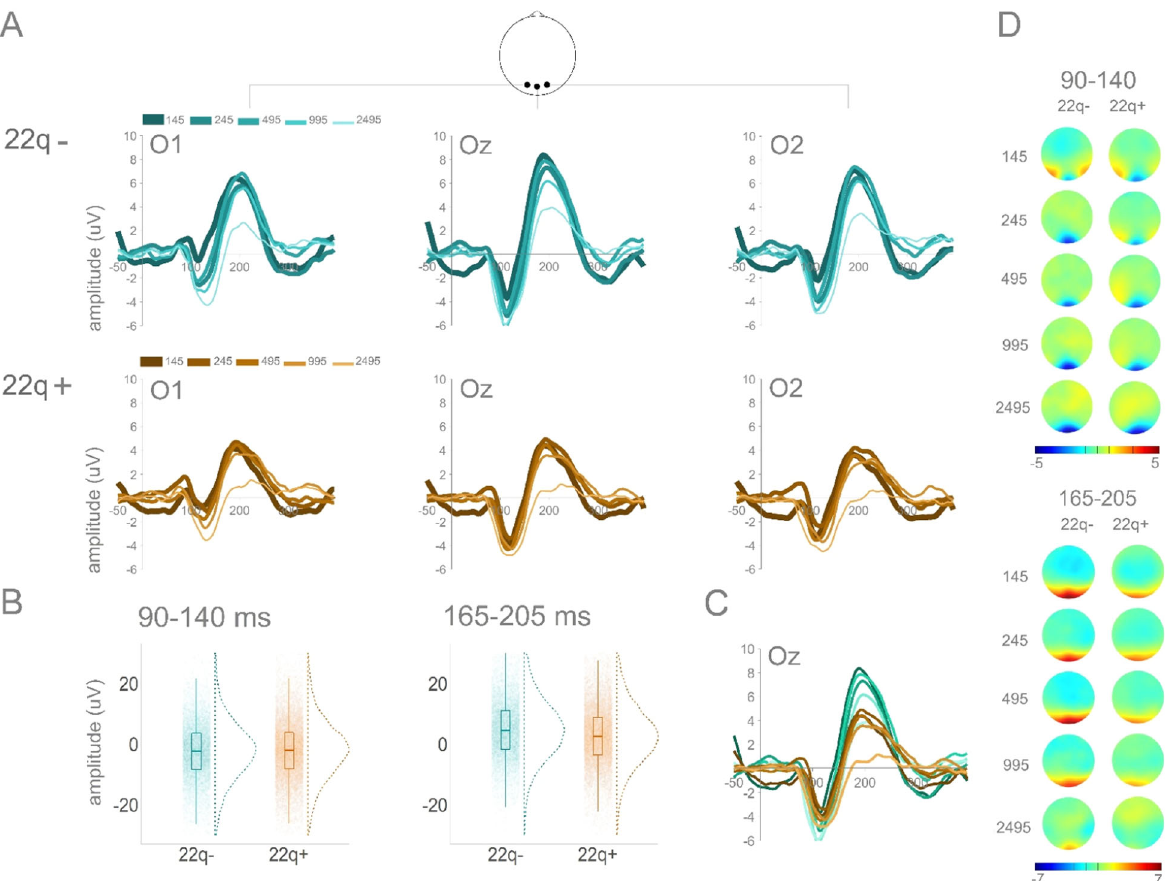
Fig. 5 22q − and 22q + : Averaged ERPs and topographies per group and ISI. A Averaged ERPs per group (22q − and 22q + ) and ISI at O1, Oz, and O2. B Plots showing distribution of amplitudes (trial-by-trial data; average of O1, Oz, and O2) for the time windows of interest (90 – 140 ms and 165 – 205 ms). C Averaged ERPs for both groups at Oz. D Topographies for windows of interest per group and ISI.